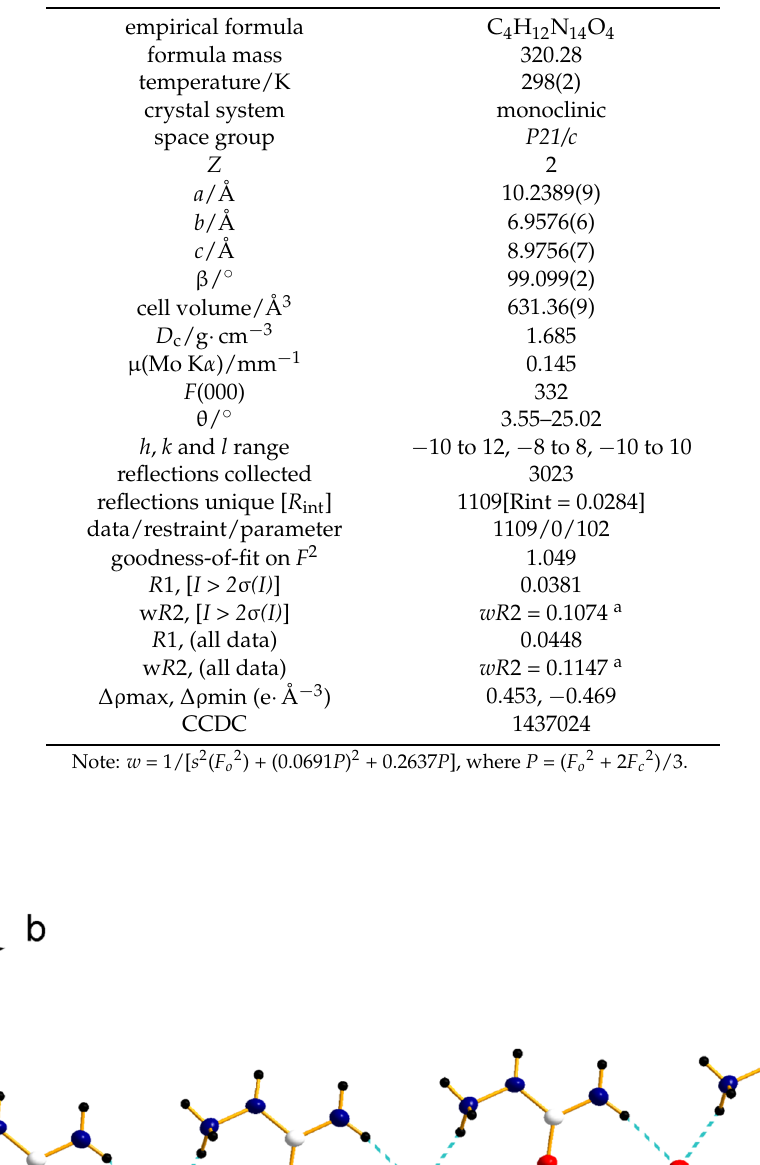
Table 1. Crystal data and structure refinement details for salt 2(SCZ) ¨ BTO.